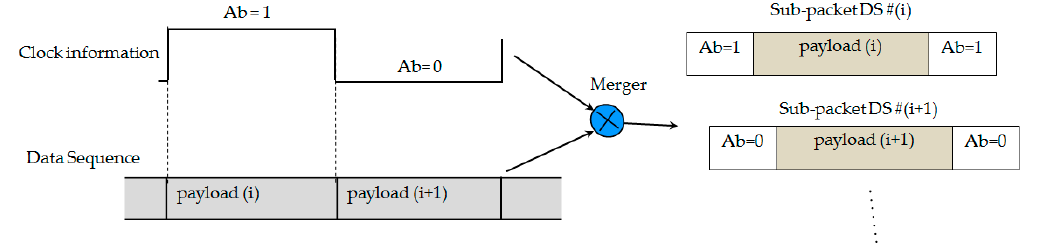
Figure 5. Merging procedure of an asynchronous bit and a payload into a sub-packet on time domain.